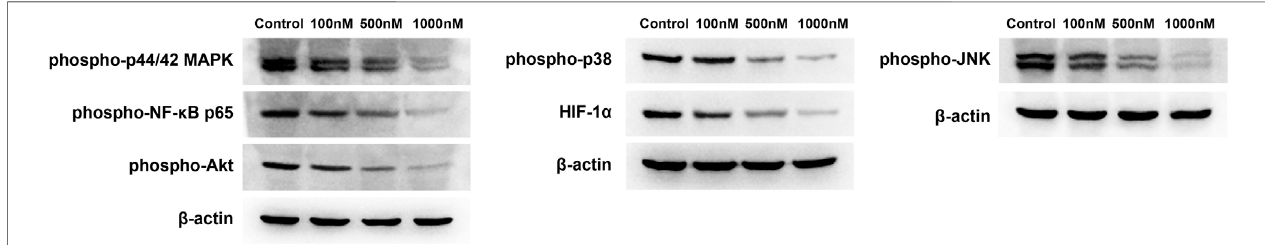
FIGURE 12 | Celastrol inhibited in fl ammatory pathways. The levels of phospho-p44/42 MAPK, phospho-NF- κ B p65, and phospho-Akt were reduced by celastrol ranging from 100 nM to 1 µM. The levels of phospho-JNK, phospho-P38, and HIF-1 α were reduced by celastrol ranging from 100 nM to 1 µM.